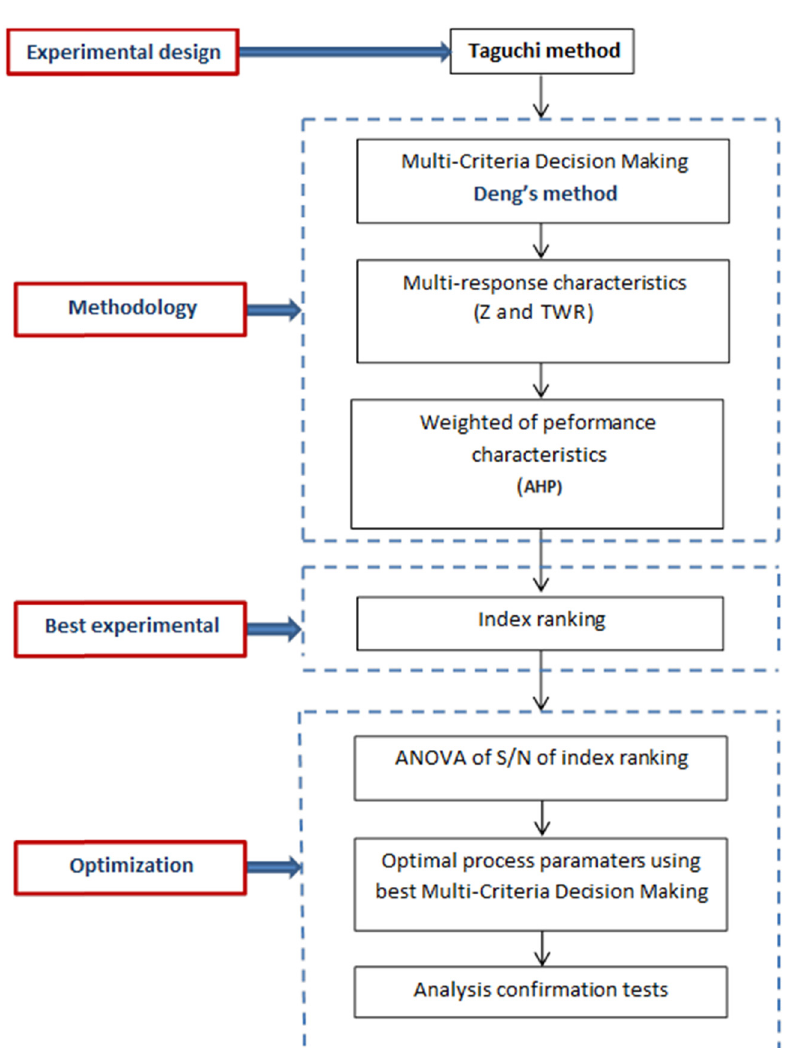
Figure 4: Steps of Taguchi – Deng ’ s